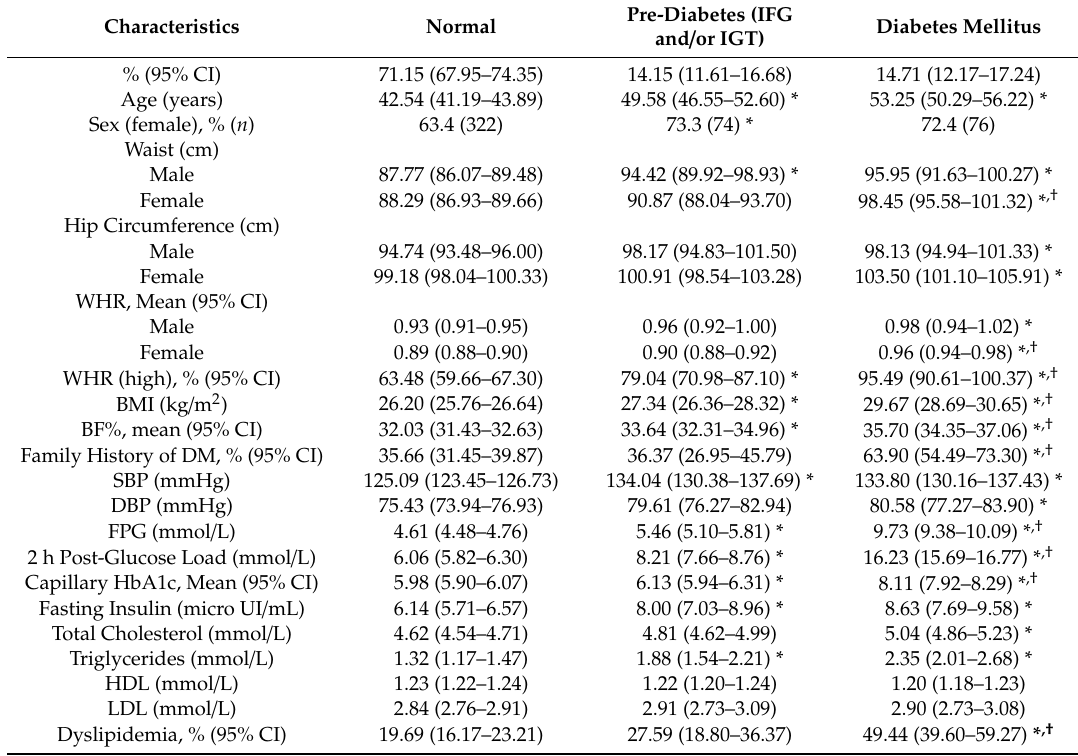
Table 1. Characteristics of 714 subjects classified as normal, pre-diabetics, or diabetics, according to the WHO